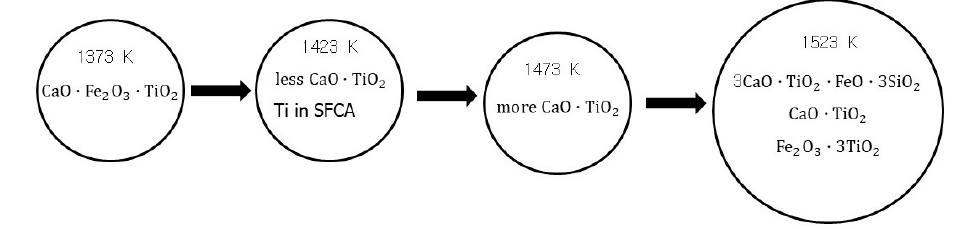
Figure 9. Summary of the location of Ti with increasing temperature in the hematite–ilmenite ore sinter. To fully utilize Ti-containing ores, low temperature sintering with an additive like B 2 O 3 should be investigated to generate more liquid phase in these